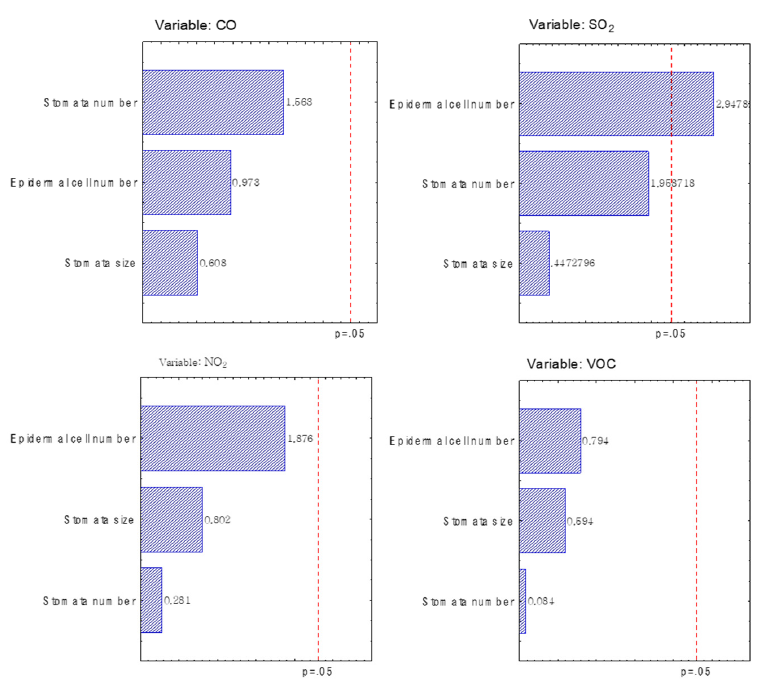
Figure 2. Pareto chart of t-values for coefficients from multiple regression for Mangifera indica